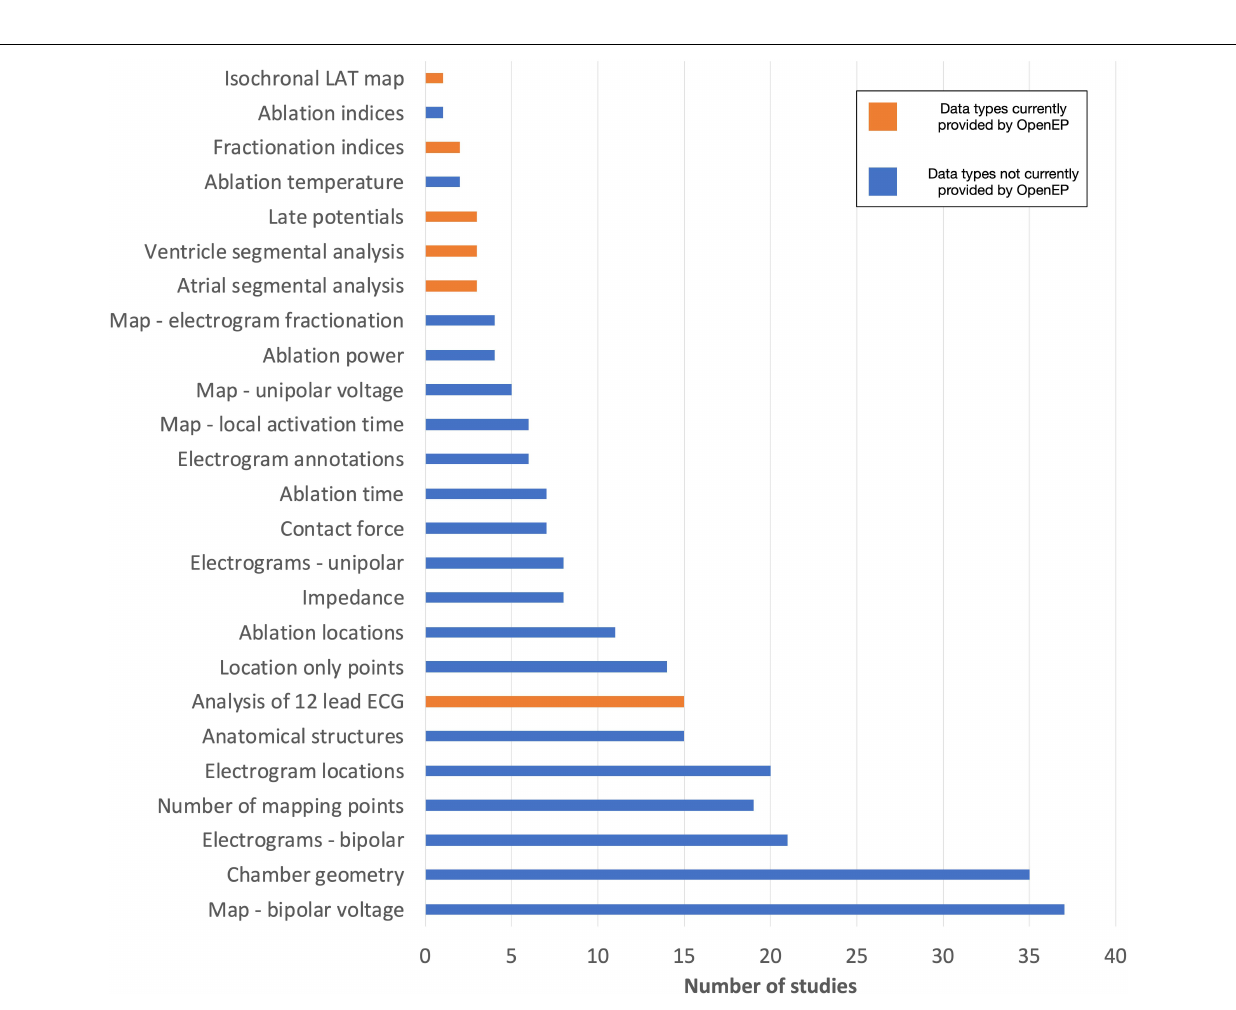
FIGURE 14 | Data types assessed by contemporary electroanatomic mapping studies. Blue bars represent the data types currently accessible through OpenEP. Orange bars represent the data types which are not currently accessible through OpenEP but which form objectives in the Roadmap for Development